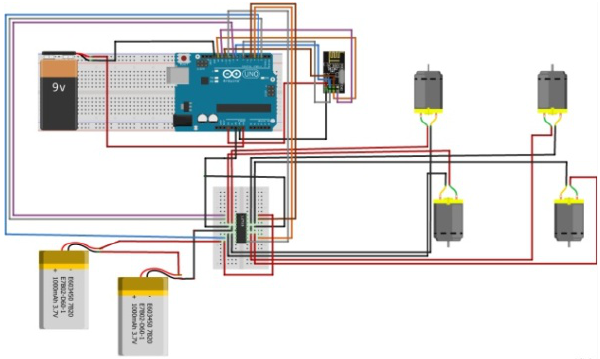
Fig. 14. Breadboard implementation of a multipurpose RC vehicle with DC